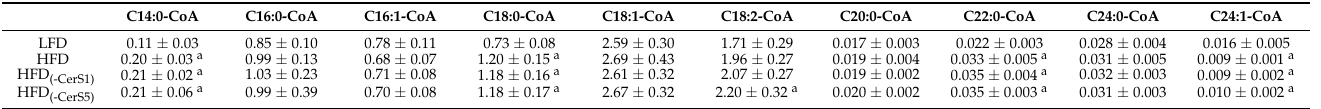
Table 2. Impact of CerS1 and CerS5 gene silencing on the content of individual long-chain acyl-CoA’s in mouse gastrocnemius muscle of HFD-fed animals. Values are mean pmol/mg of tissue ± SD; n = 8 per group; a — p < 0.05 vs. LFD.